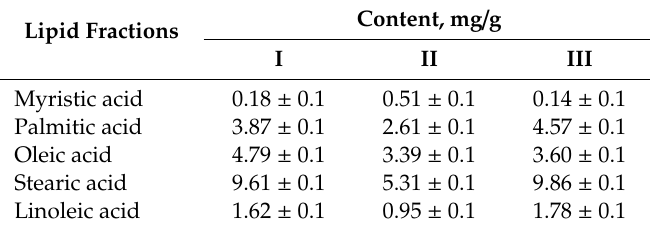
Table 5. Fatty acid composition of the lipid fraction of the microalgae lipid